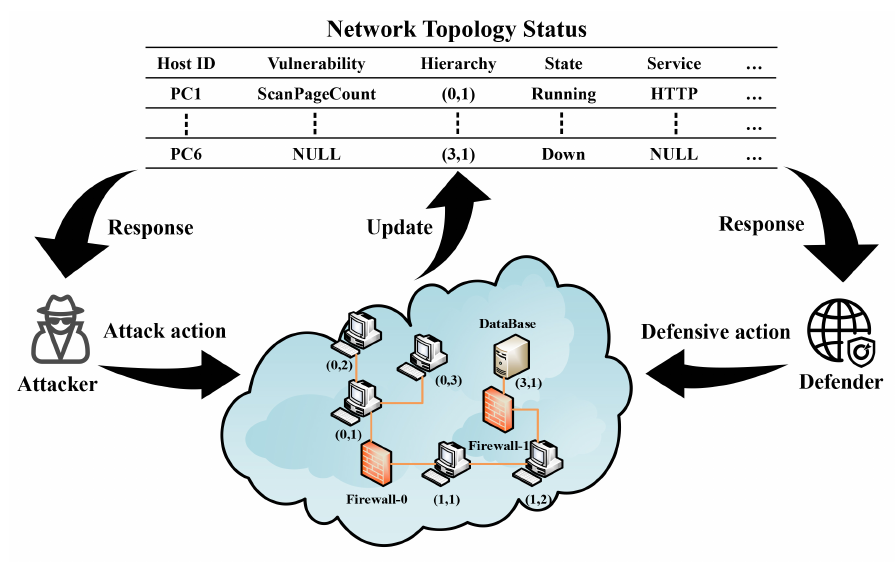
Figure 6. The interaction between the penetration tester and network